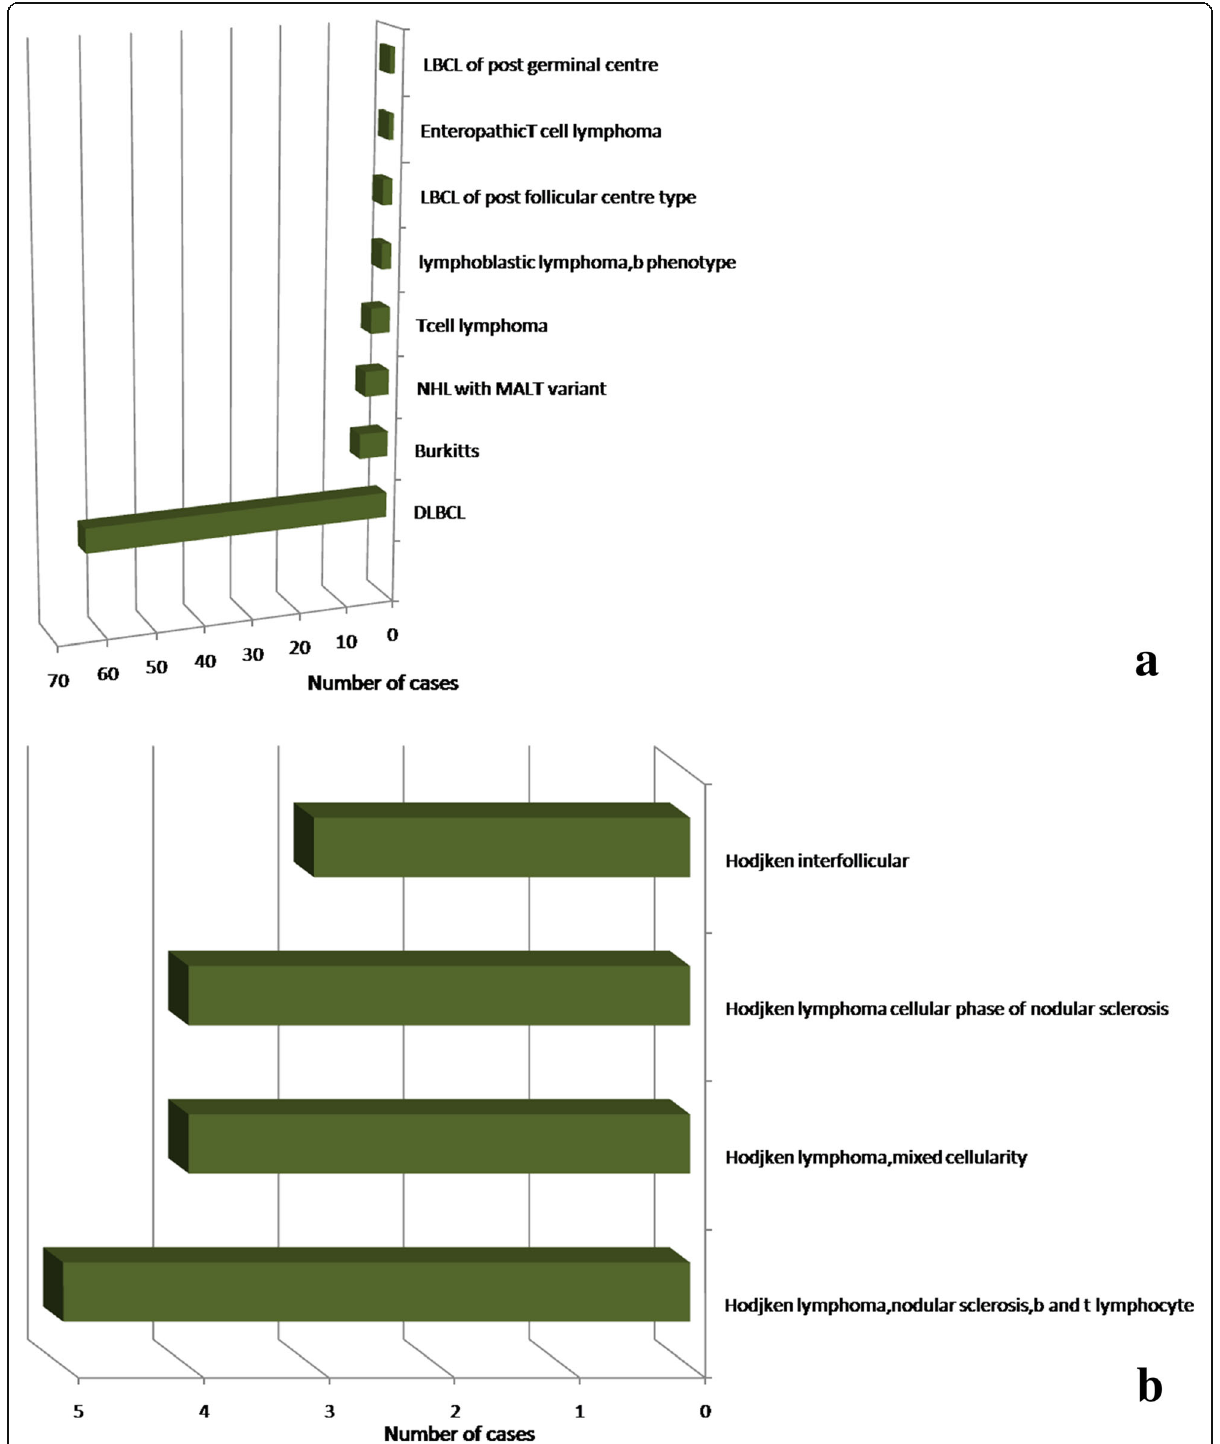
Fig. 1 Charts represent NHL (chart a ), HD (chart b ) histological